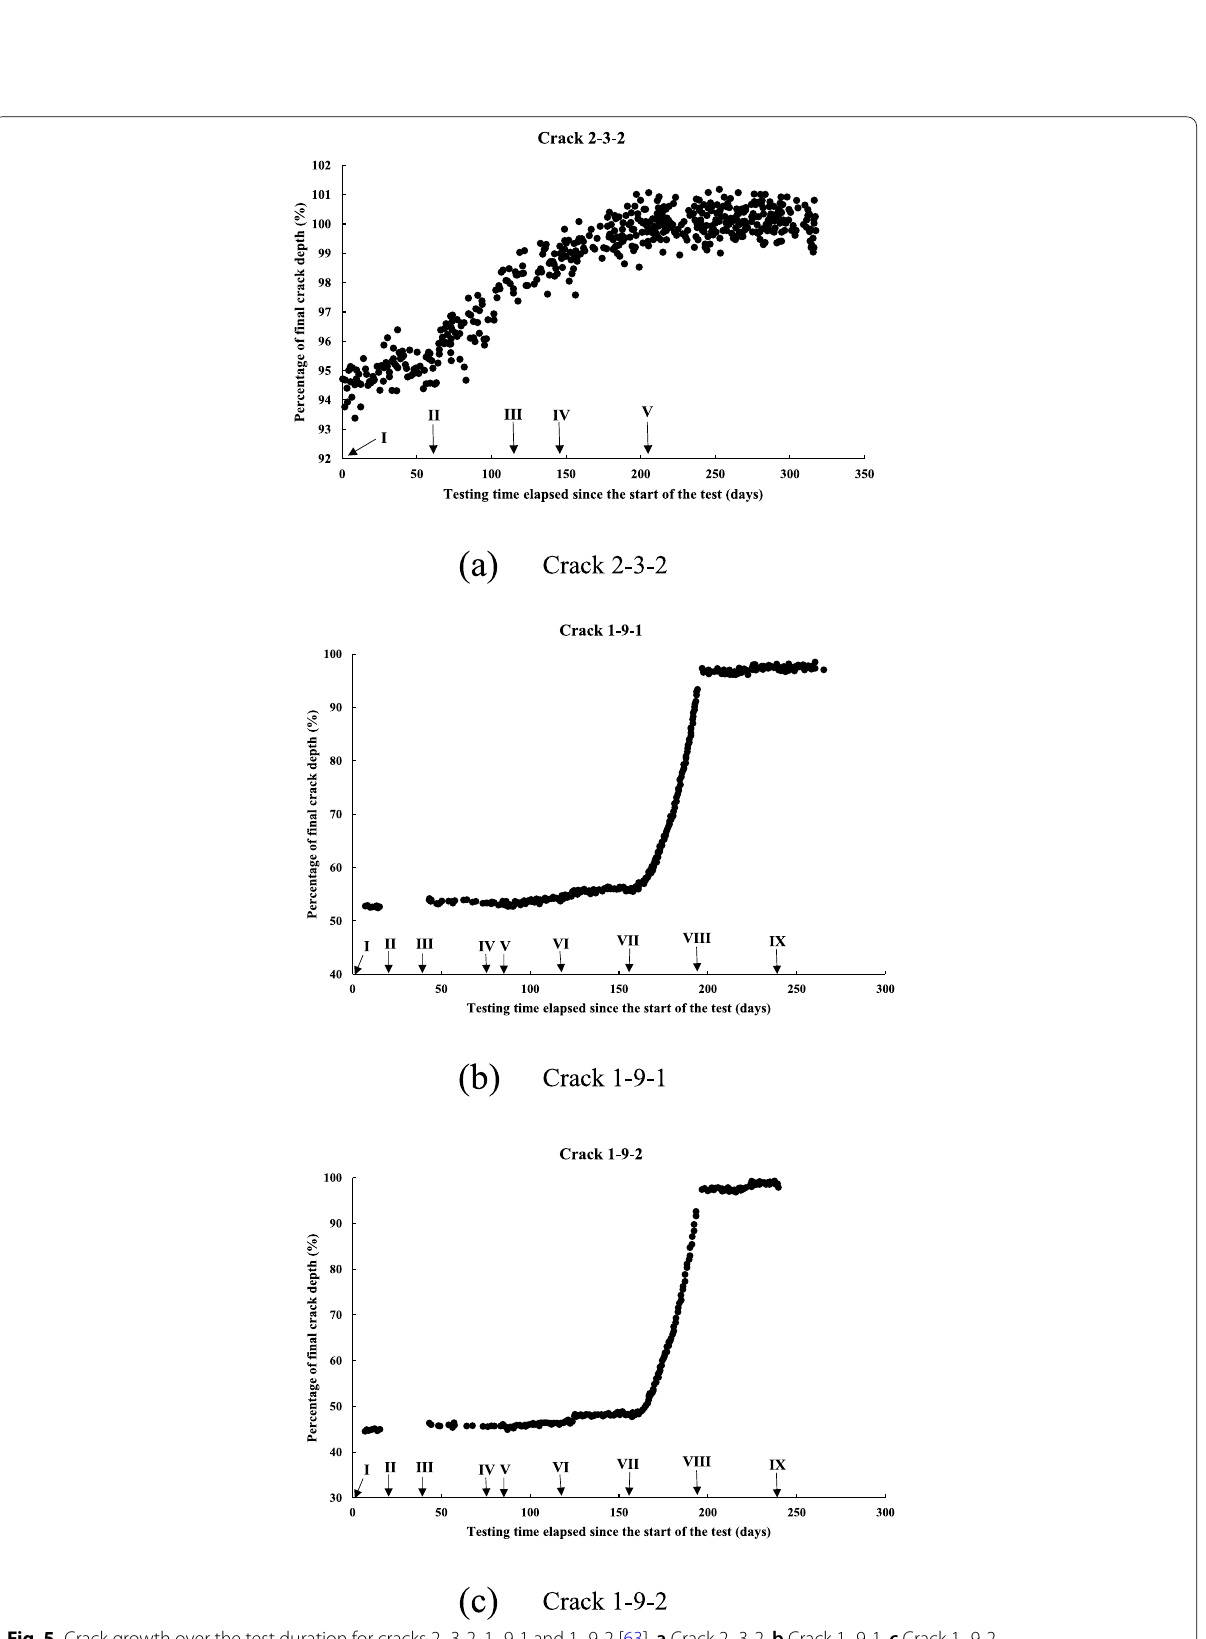
Fig. 5 Crack growth over the test duration for cracks 2–3-2, 1–9-1 and 1–9-2 [63]. a Crack 2–3-2. b Crack 1–9-1. c Crack